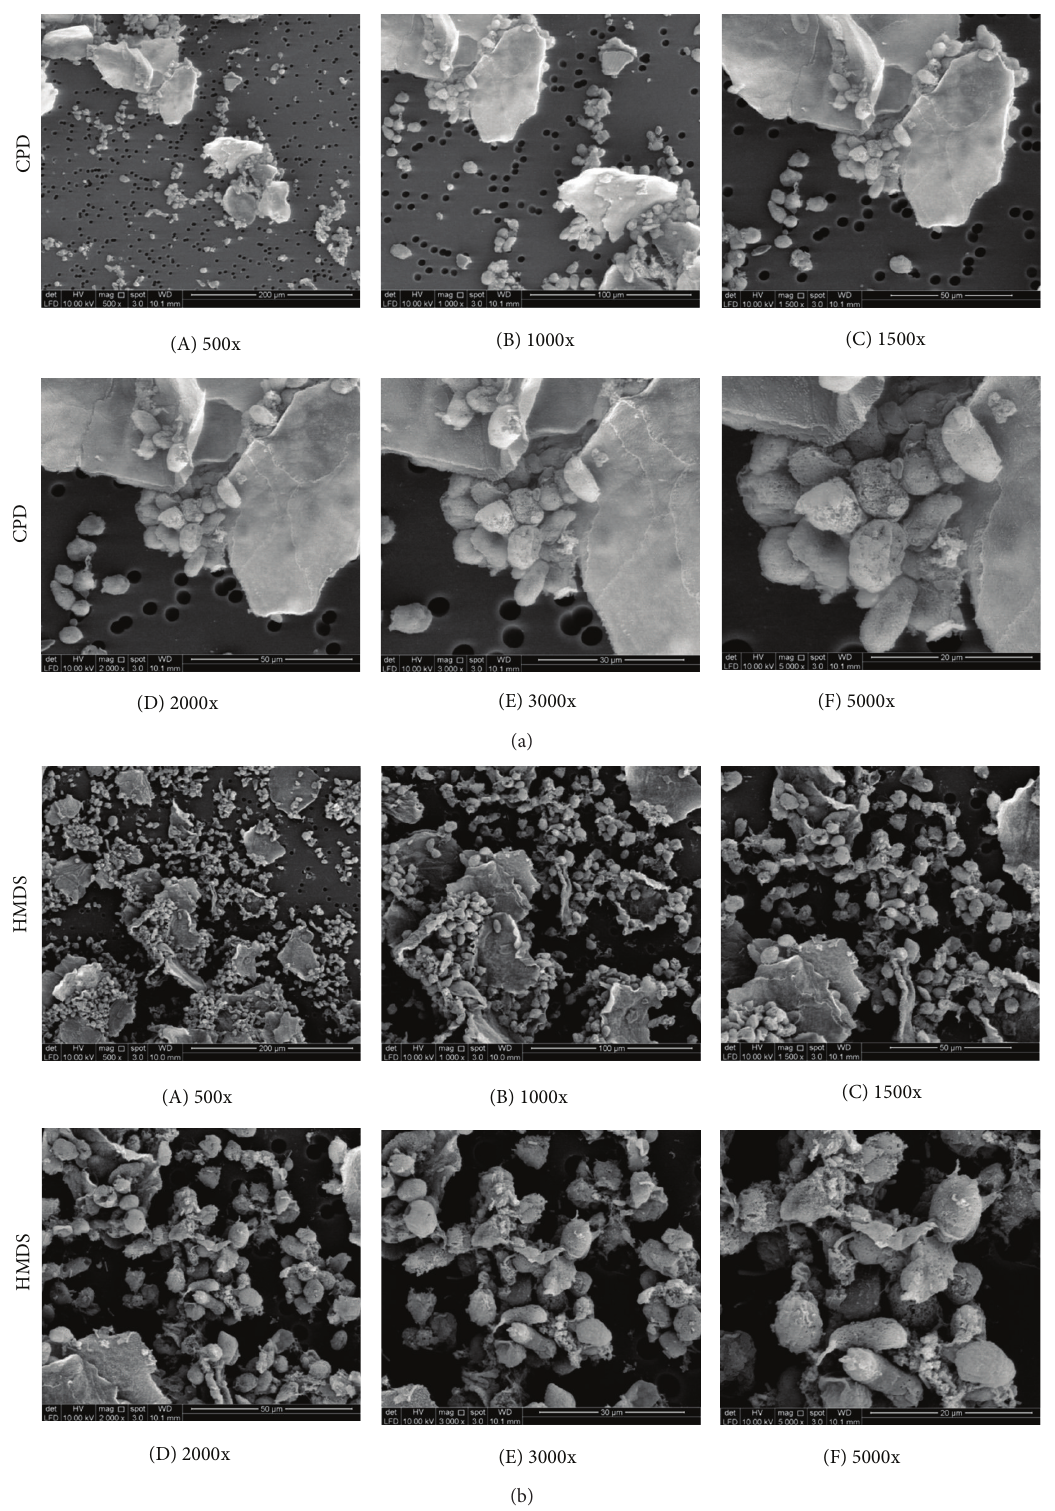
Figure 6: FE-SEM images of sample “a” preparation based on CPD and HMDS techniques in different magnification levels. (aA) 500x magnification, (aB) 1000x magnification, (aC) 1500x magnification, (aD) 2000x magnification, (aE) 3000x magnification, and (aF) 5000x magnification based on CPD technique and then (bA) 500x magnification, (bB) 1000x magnification, (bC) 1500x magnification, (bD) 2000x magnification, (bE) 3000x magnification, and (bF) 5000x magnification based on HMDS